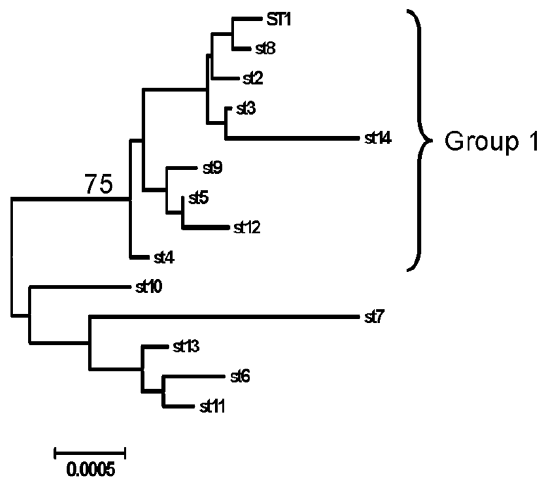
Figure 4. Neighbour-joining tree of the concatenated sequences ofB. henselaeSTs as reconstructed by MEGA4. 1,000 bootstrap replicates were used to examine the confidence in the tree. The only node to score above 60 is the one leading to Group 1 (75%, as indicated), indicating that the delineation of Group 1 represents a real division in the B. henselae